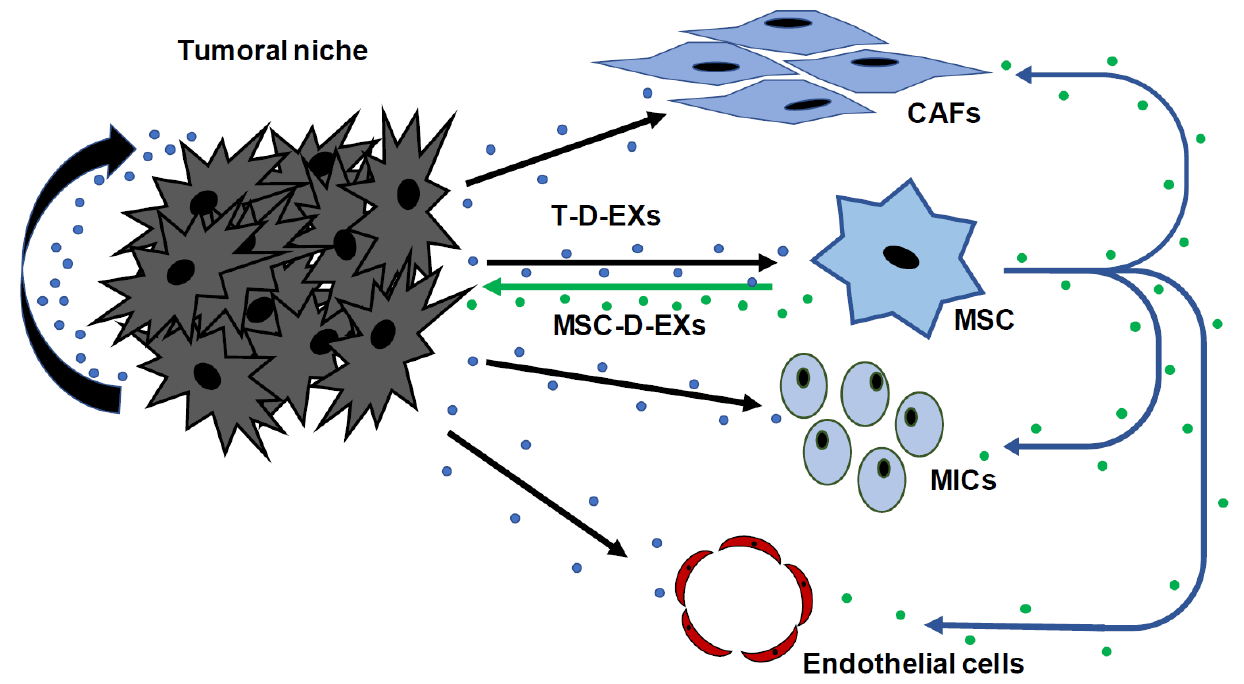
Figure 4. Schematic representation of paracrine interactions through exosomes among different cell types from prostate carcinomas. T-D-EXs: tumor-derived exosomes; MSC-D-EXs: mesenchymal stem cell-derived exosomes; CAFs: cancer-associated fibroblasts; MICs: mononuclear inflammatory cells.